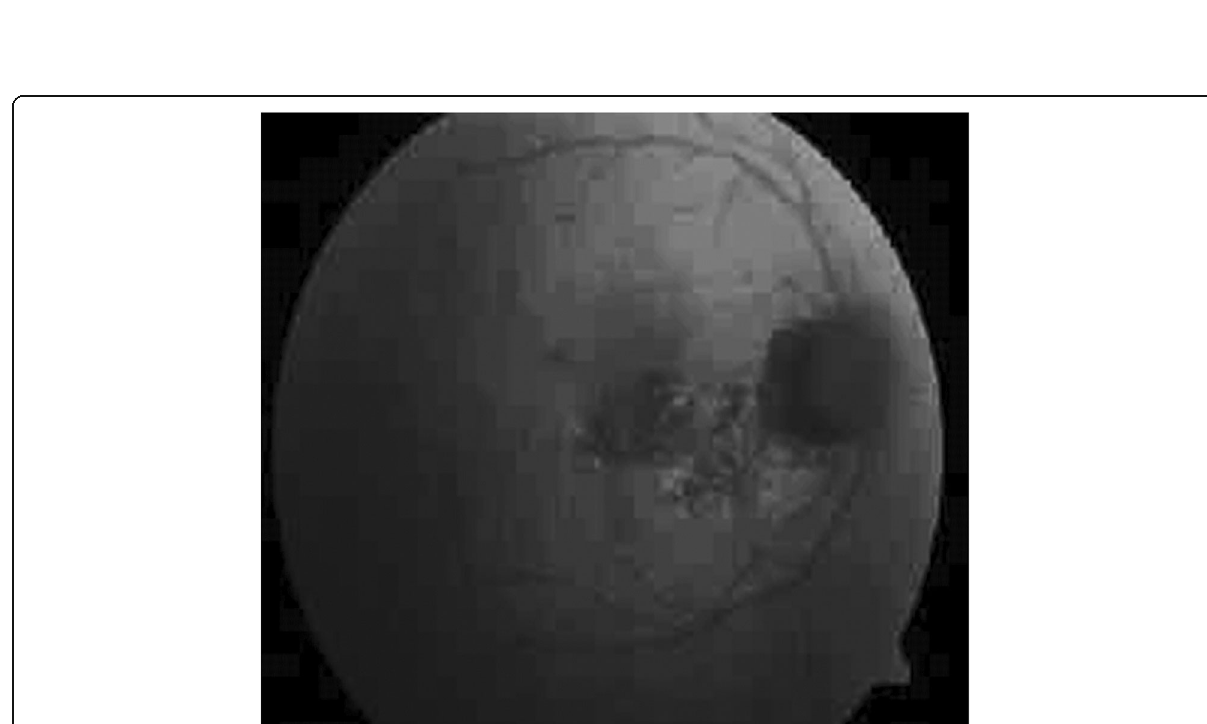
Fig. 2 Retinal Pigmented Epithelium by fundus autoflourscent